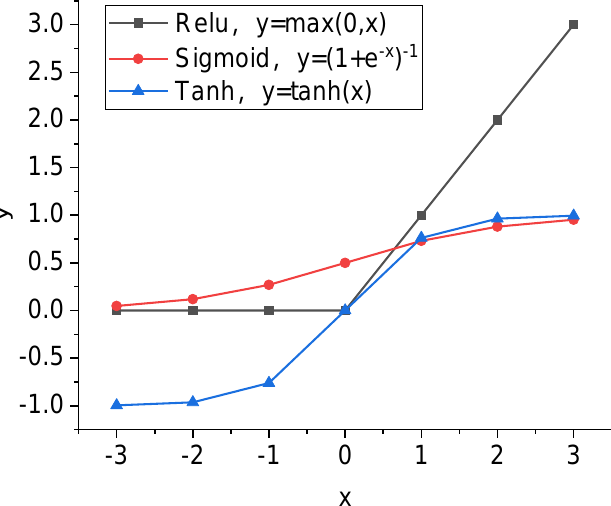
Figure 4. Examples of commonly used activation functions for neural networks.